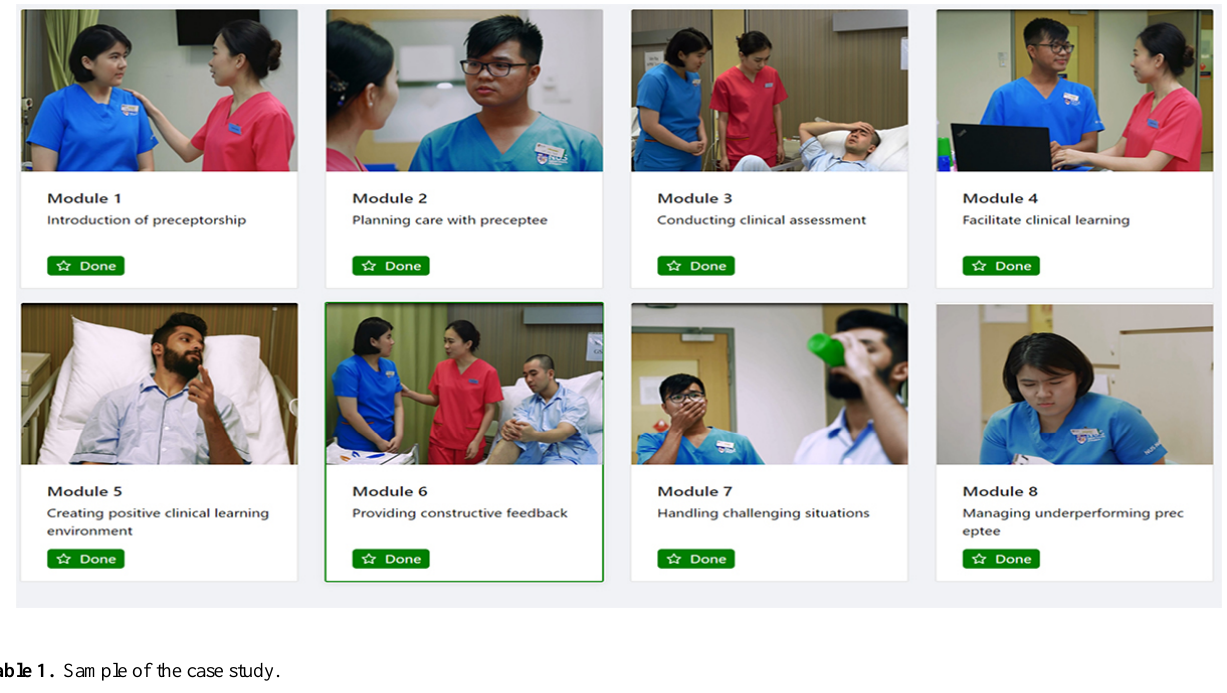
Figure 1. Modules in the web-based clinical pedagogy program.